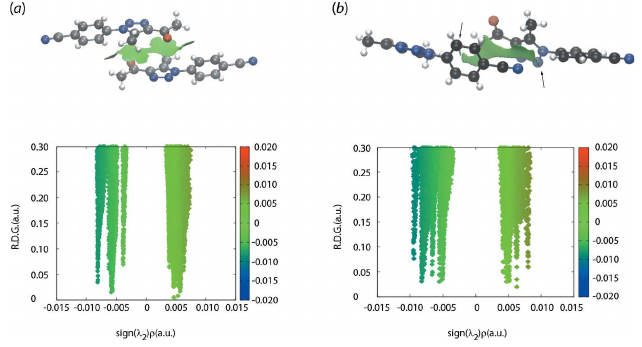
Figure 7 Non-covalent interaction plots for the ( a ) carbonyl-C O (cid:3)(cid:3)(cid:3) (cid:2) (triazolyl) and ( b ) cyano-C N (cid:3)(cid:3)(cid:3) (cid:2) (triazolyl) interactions. The arrows in ( b ) indicate attractive phenyl-C—H (cid:3)(cid:3)(cid:3) N(cyano) interactions (see